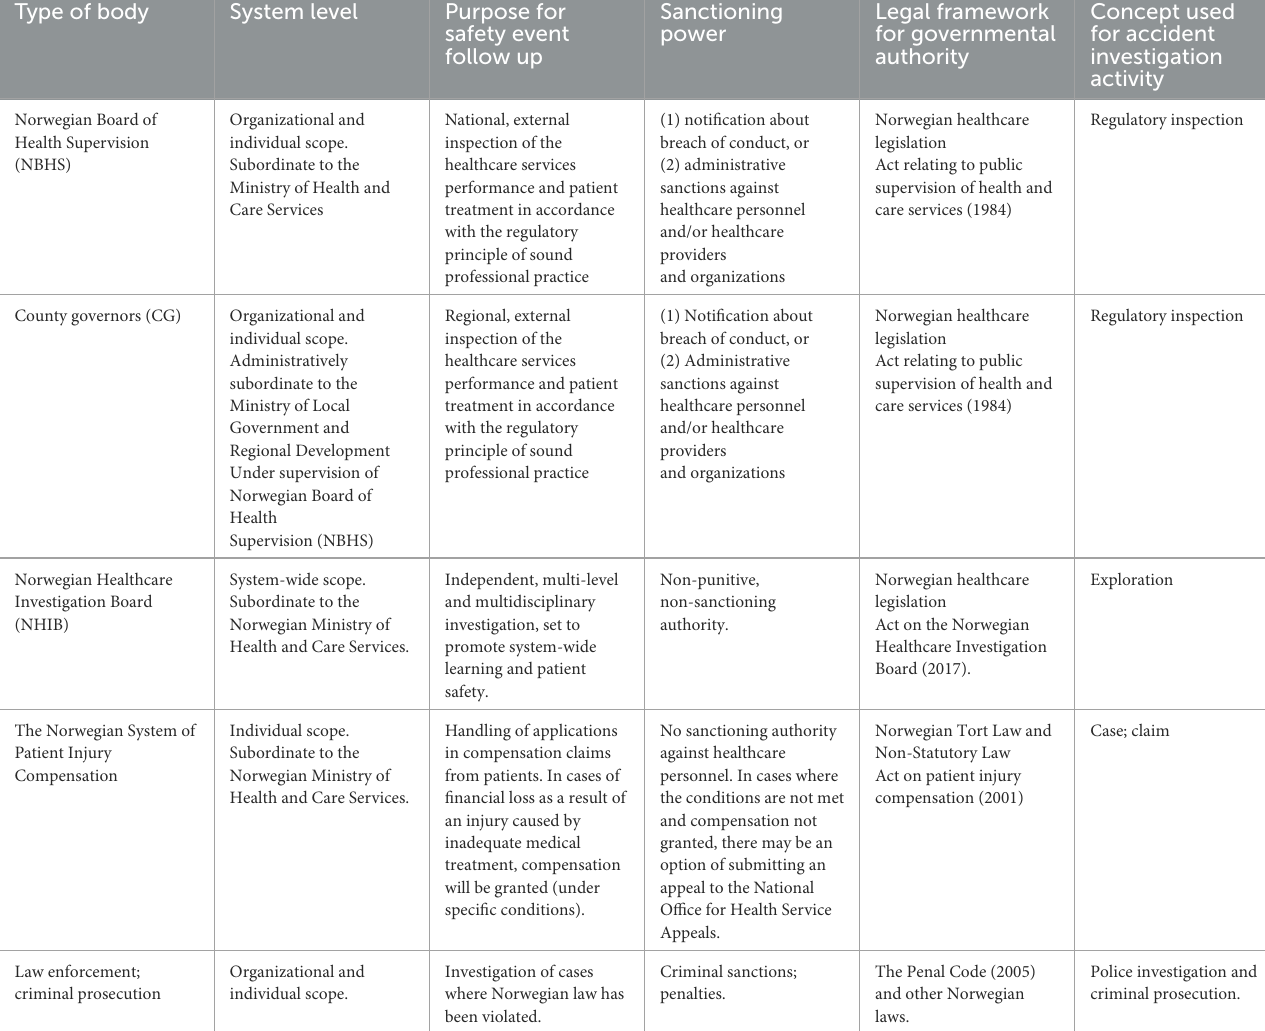
TABLE 1 Overview of main bodies from the Norwegian context and their role and mandate in following up of adverse events. Type of